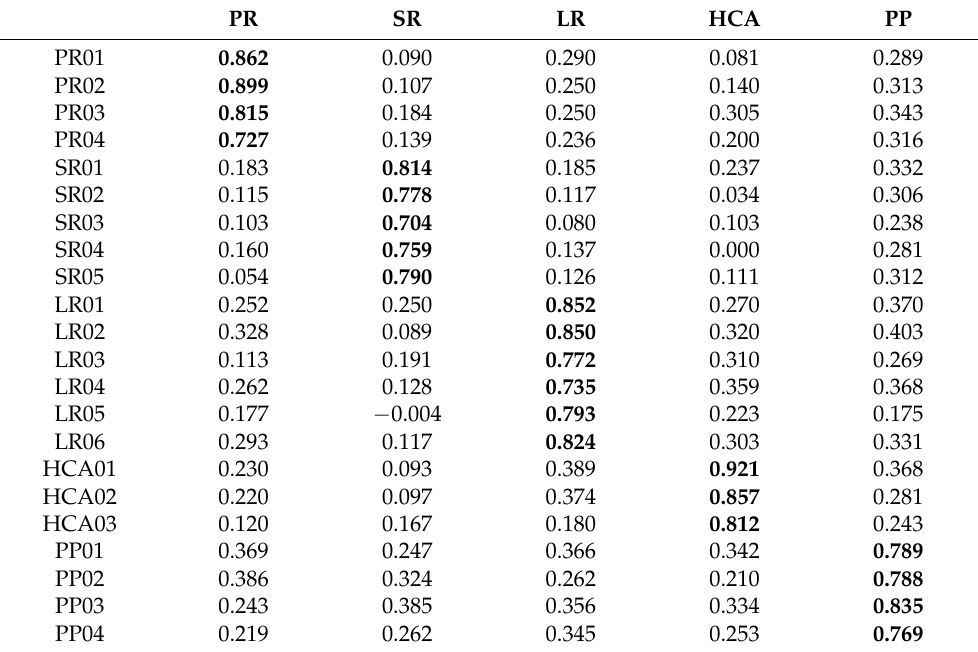
Table 7. Cross-loadings of the variables.